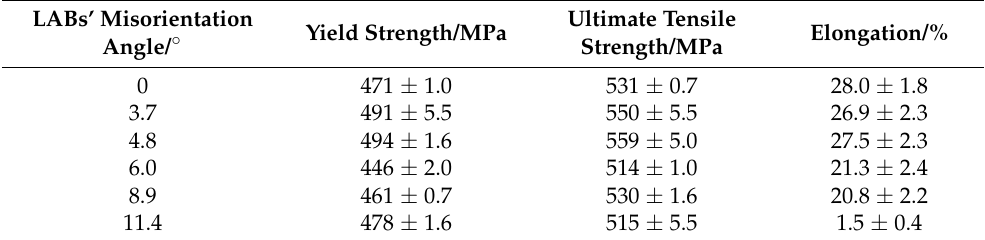
Table 1. Tensile properties of DD9 alloy with LABs at 1100°C.